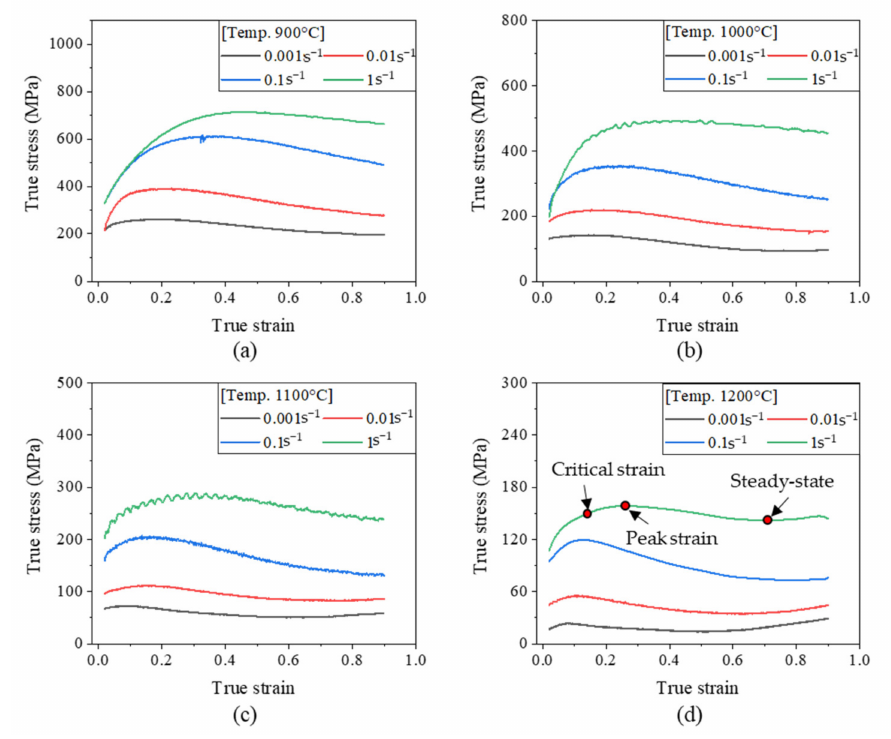
Figure 2. A230 flow stress curves measured at ( a ) 900, ( b ) 1000, ( c ) 1100 and ( d ) 1200 ◦